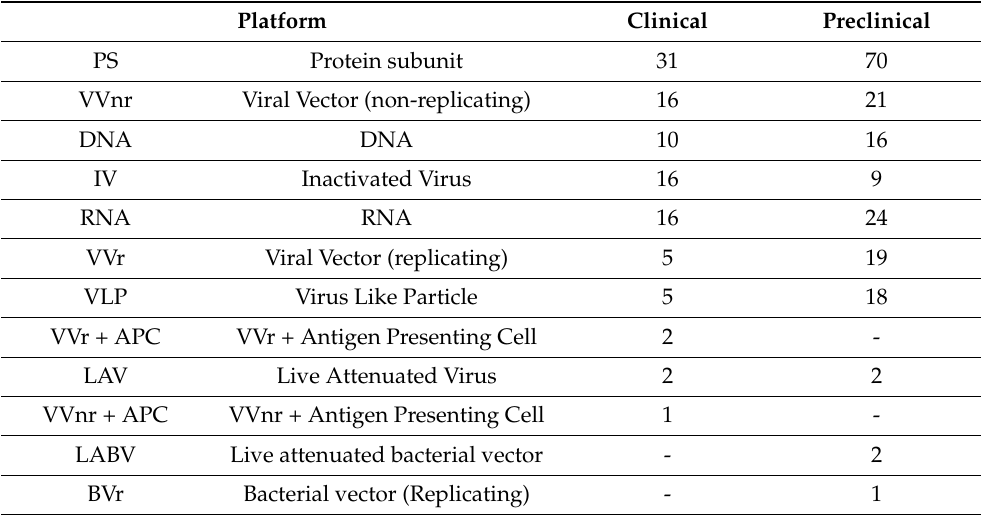
Table 2. Number of COVID-19 vaccine candidates and platforms in the late stage pre-clinical and clinical